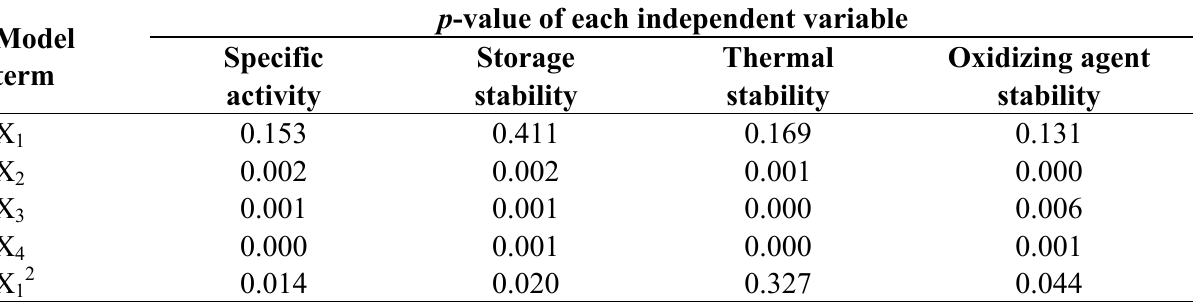
Table 2. p -value of each independent variable effect in polynomial response surface